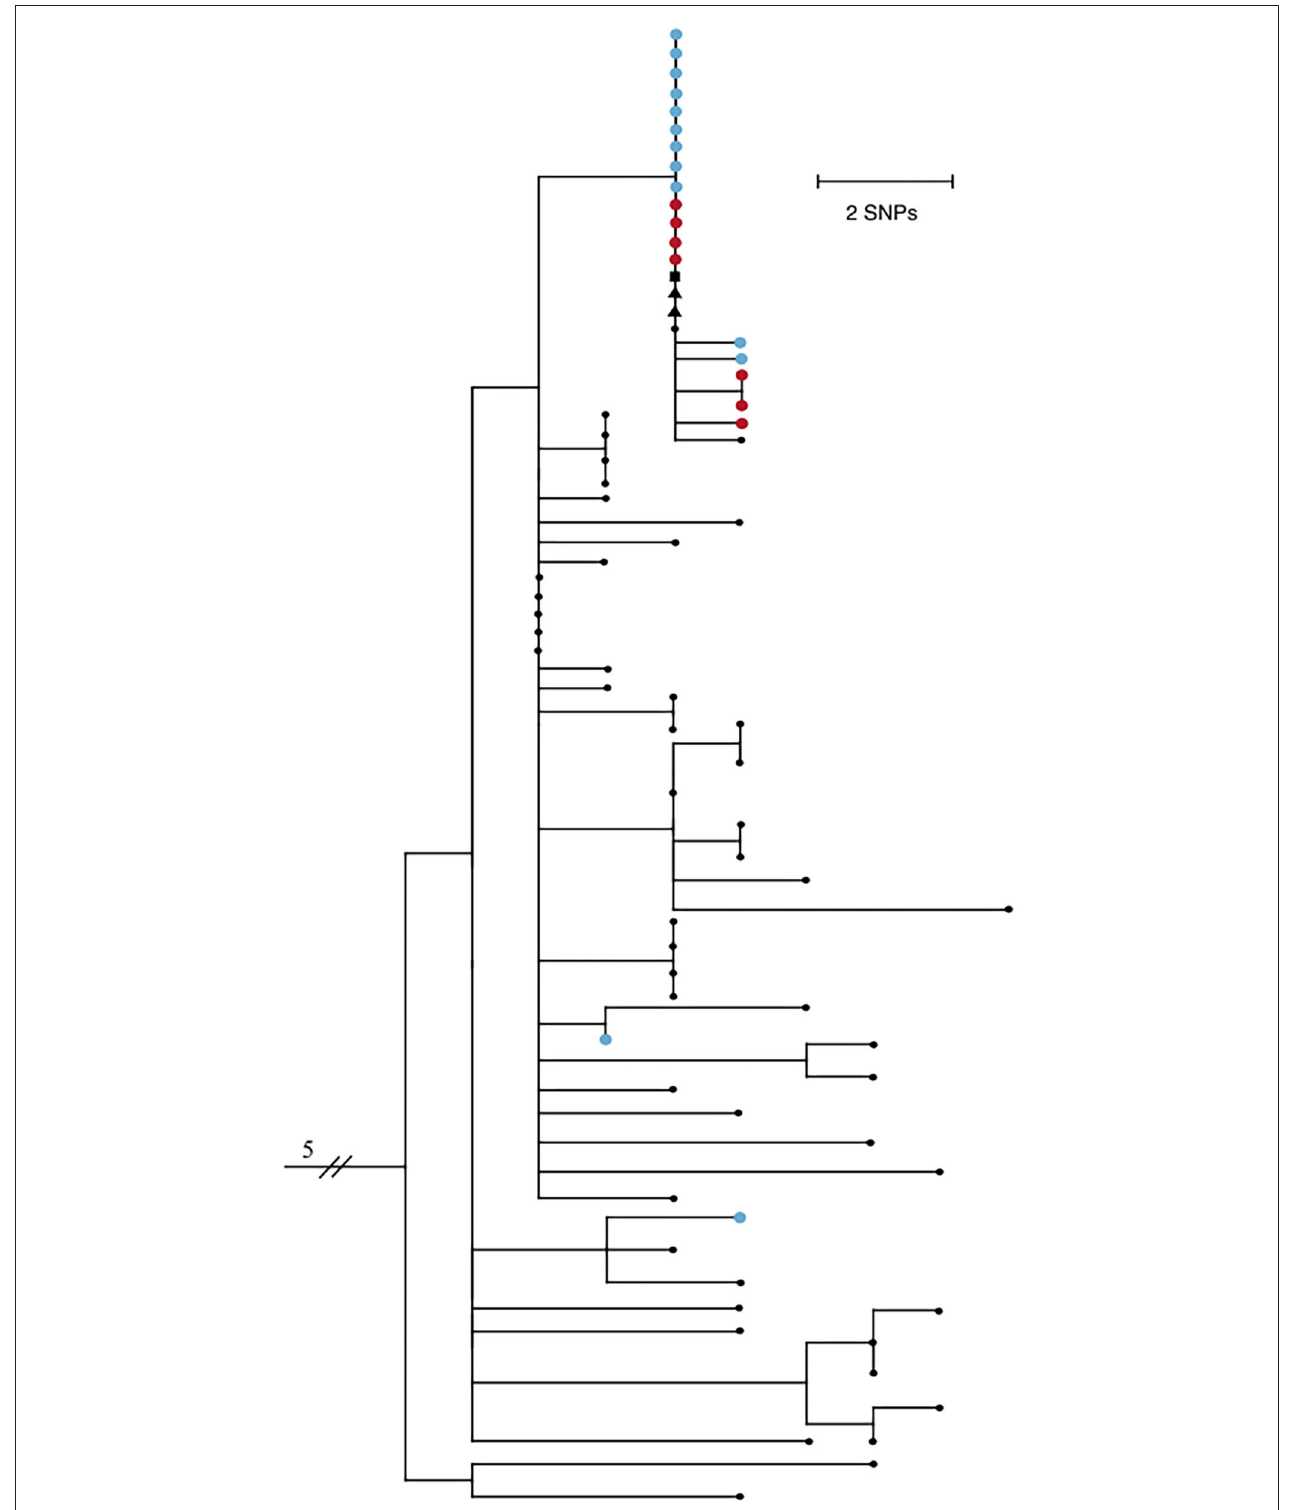
FIGURE 1 | Maximum likelihood phylogenetic tree of 74 SARS-CoV-2 genomes from Northern Arizona, May-June 2020 generated by Nextstrain (13, 14) using the Wuhan1 genome as a reference (EPI_ISL_402125), showing 18/20 samples sequenced from this outbreak form one tight clade. Blue nodes represent sequences